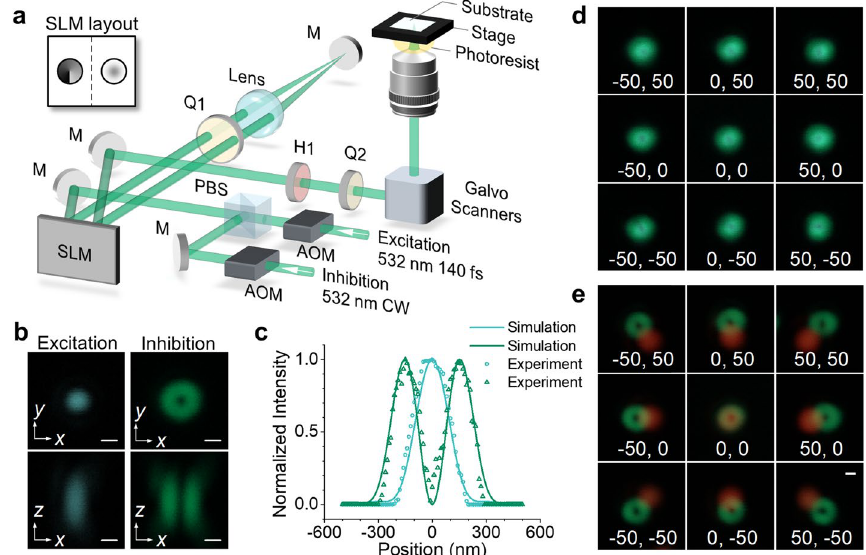
Fig. 1 Single-color peripheral photoinhibition lithography system. a Optical setup. CW: continuous wave, AOM: acoustic optical modulator, PBS: polarizing beam splitter, SLM: spatial light modulator, Q1 & Q2: quarter-wave plates, H1: half-wave plate, M: mirror. b The laser focus was measured by scanning a 150-nm-diameter gold bead in three dimensions. Cuts within the x–y and x–z plane are presented. c Simulated and experimental intensity distribution of the solid-shaped excitation beam and doughnut-shaped inhibition beam. d, e Images of light scattered from 150 nm diameter gold beads over a FOV of 100 100 μm 2 in SC-PPI (d) and two-color PPI (e). The coordinates at the bottom of each subplot indicate the × center positions of each region. The units of the coordinates in d and e are microns. Scale bar: 200